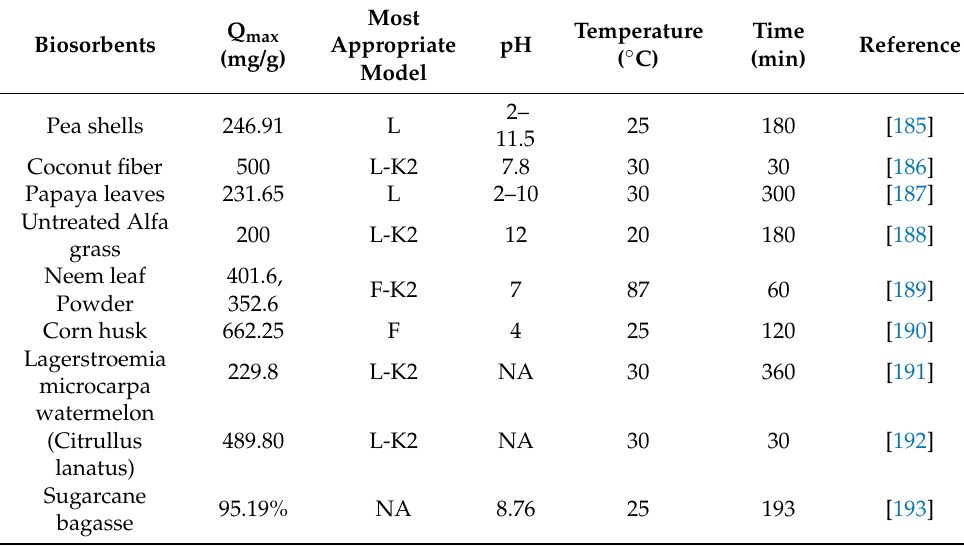
Table 5. Summary of bio-waste-derived adsorbent studies in 2013.